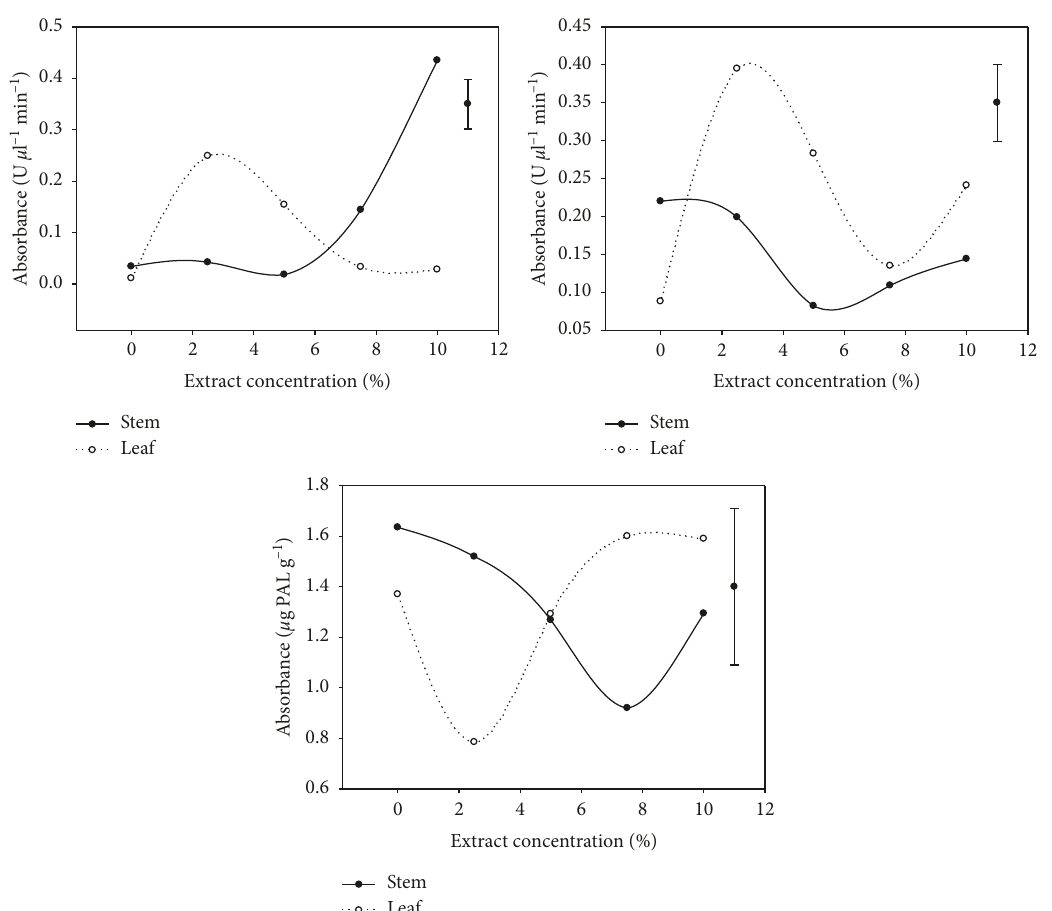
Figure 2: Effect of different concentrations of sorghum leaf and stem aqueous extracts on POD, PPO, and PAL activity in black jack. Errors bars indicate LSD at p < 0 . 05.